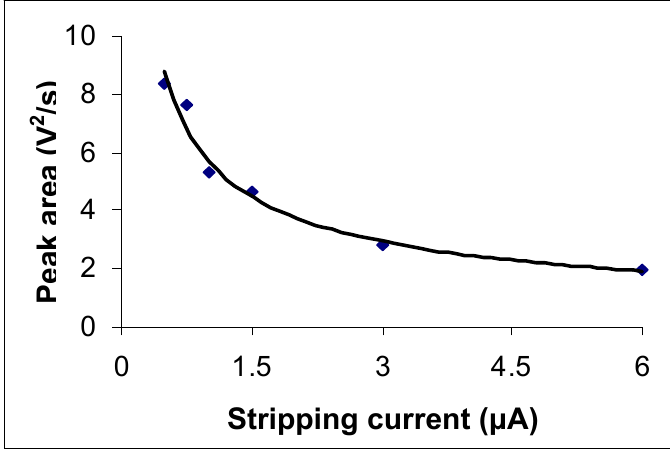
Figure 4 . Influence of redissolution current applied to the working electrode on the mercury analytical signal. Mercury concentration was 50 μ g/L. Experimental conditions were as described at the working procedure.